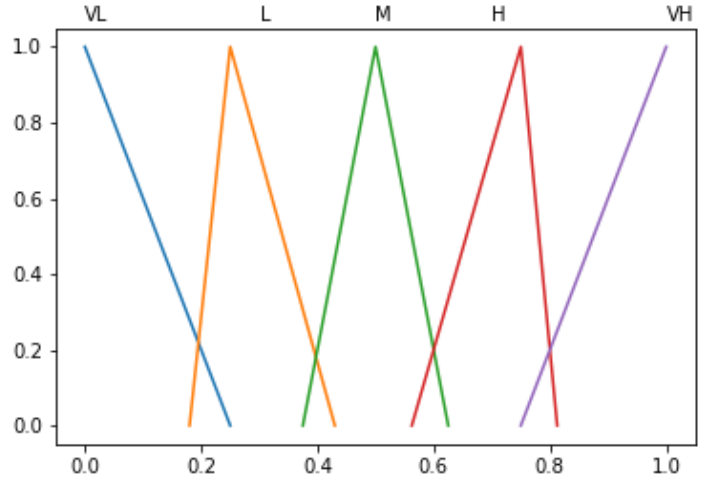
Figure 6. Fuzzy sets for the preference strength to travel to customer i